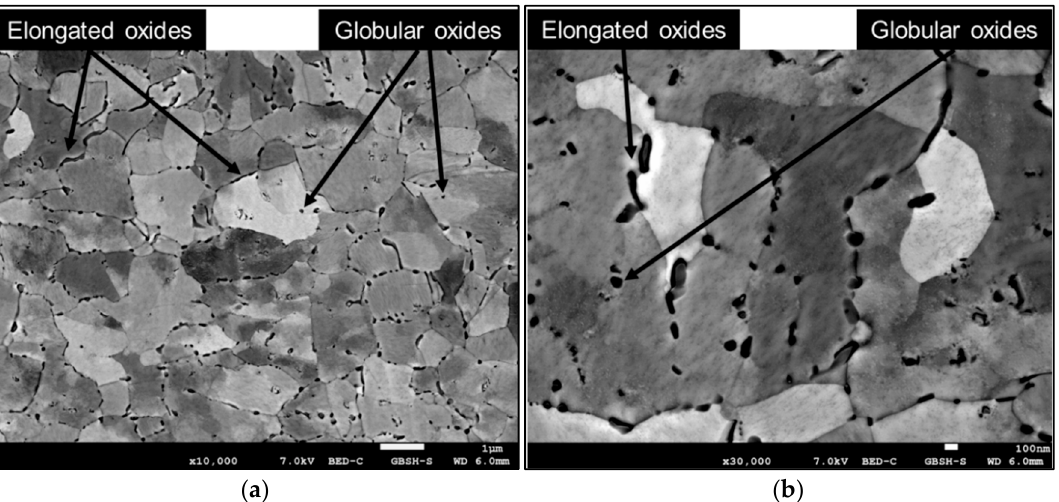
Figure 6. SEM micrograph of the internally oxidised microstructure from the top layer of the ribbon (CEG zone after RS): ( a ) overview of the top layer; ( b ) detail from the top layer.